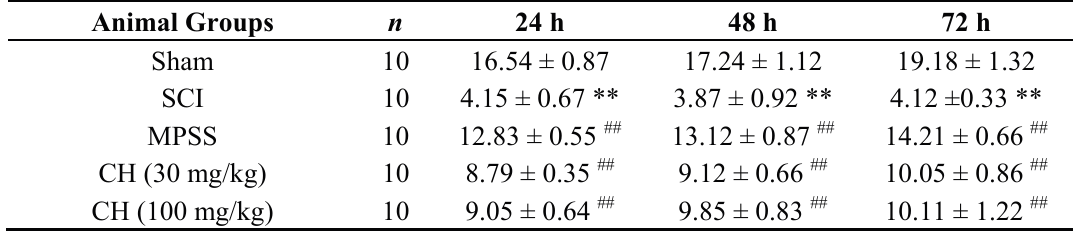
Table 1. BBB (Basso Beattle Bresnahan) scores for rats at 24, 48 and 72 h after SCI (spinal cord injury). MPSS, methylprednisolone; CH, chrysin.